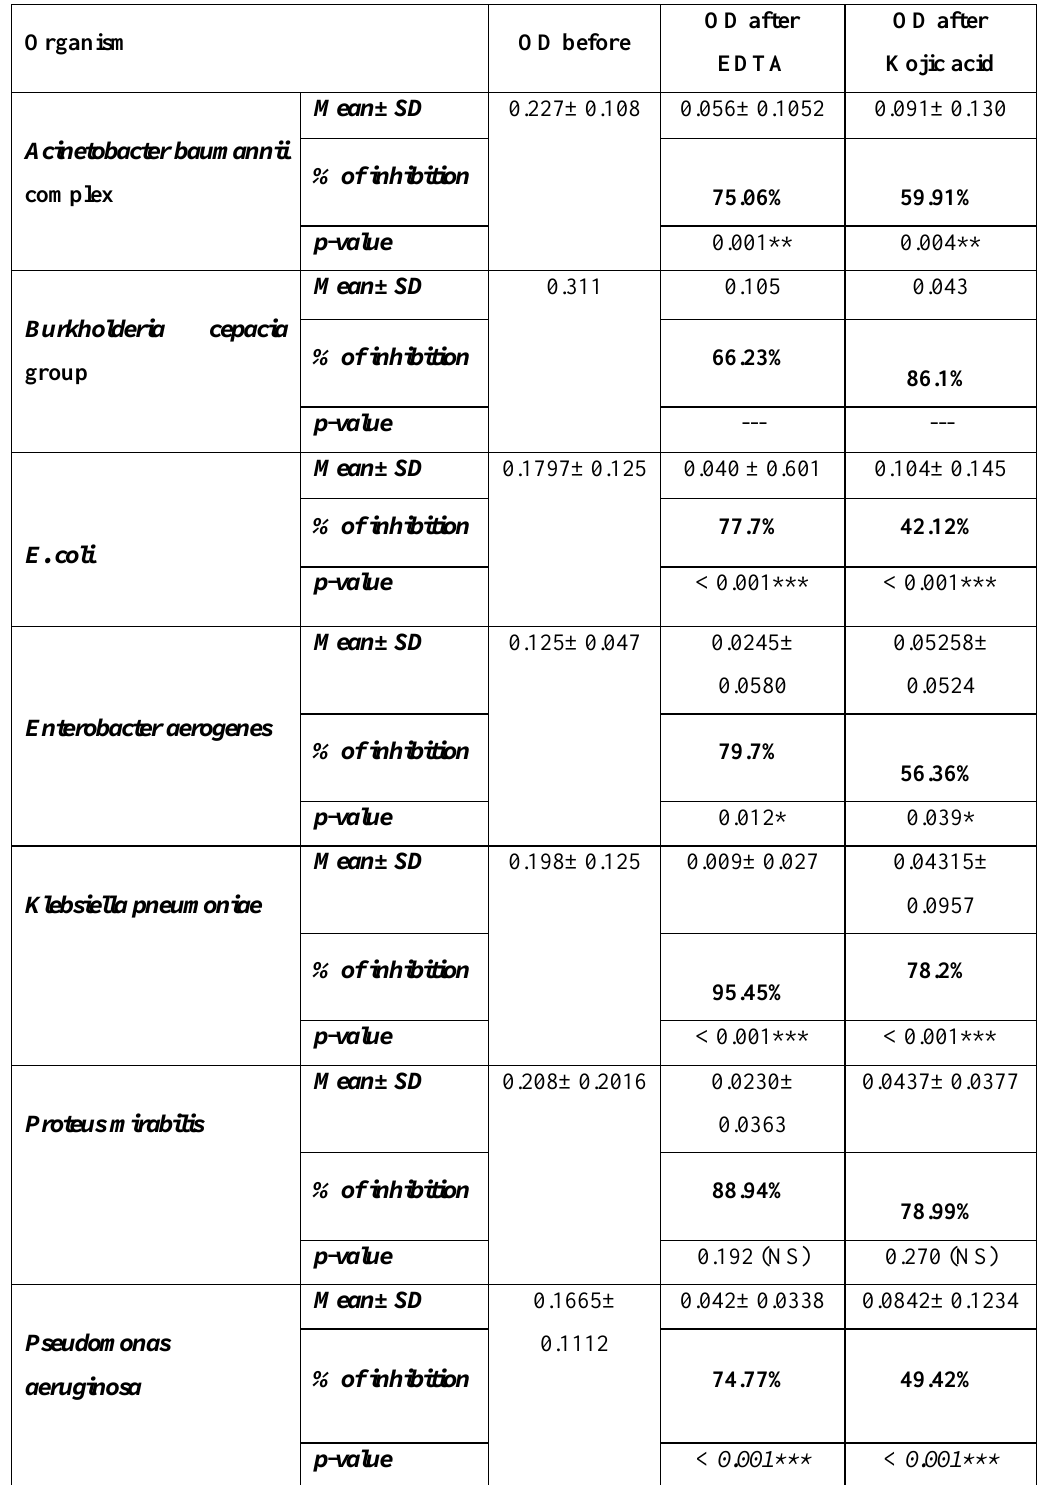
Table 2. Effect of EDTA and Kojic acid on different biofilm-forming